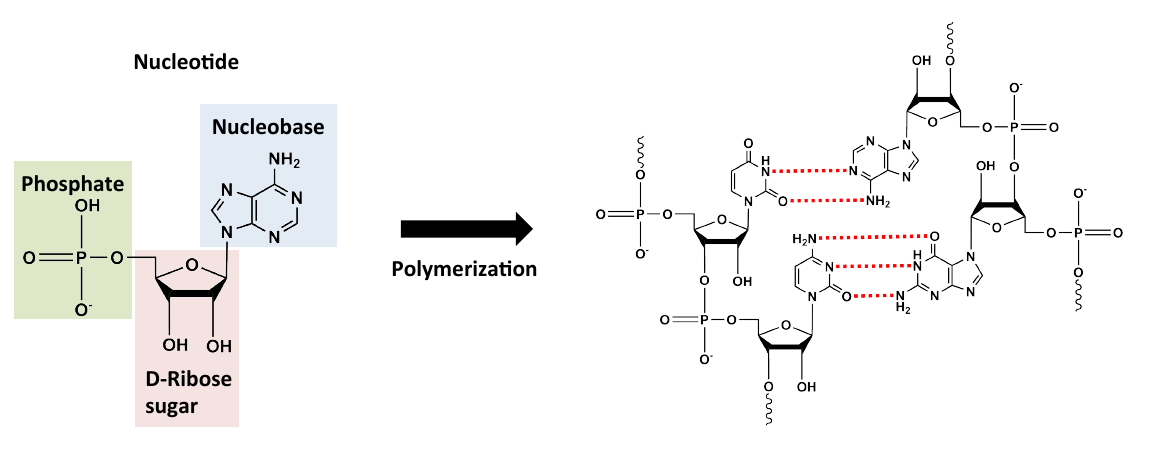
Figure 2. The components of ribonucleic acid (RNA). The nucleotide monomer is comprised of a nucleobase (A, G, C, U), the sugar ribose, and a phosphate group. The nucleotides polymerize, thereby storing information through the sequence of bases. Polymers strands then base pair with their complementary bases via hydrogen bonding. In DNA, uracil is replaced with thymine. Beyond hydrogen bonding, DNA further assembles